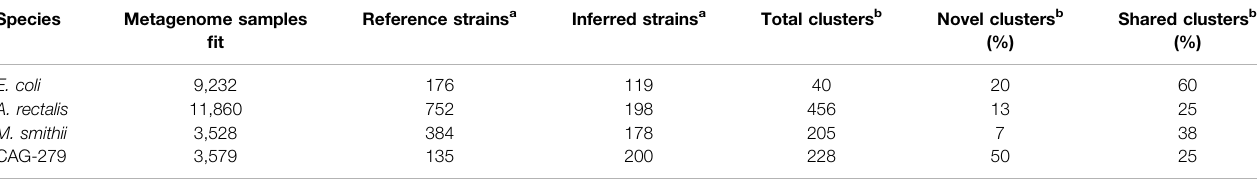
TABLE 3 | Dereplication and co-clustering of strains inferred from metagenomes or from a reference database.